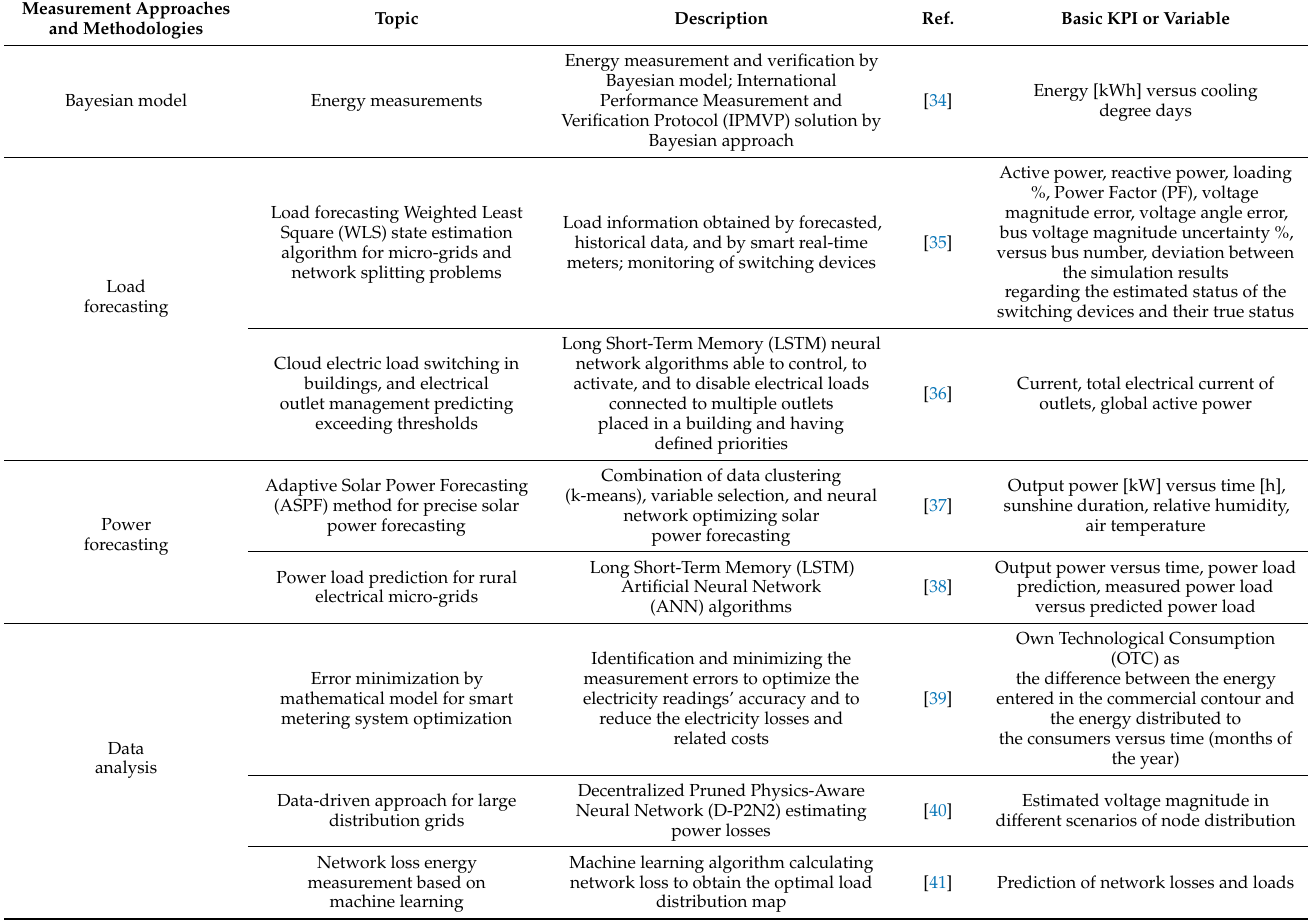
Table 3. State of the art: advanced measurement approaches and